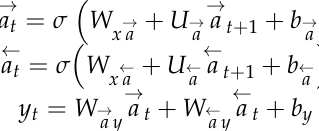
Figure 5. Structure of a LSTM unit.